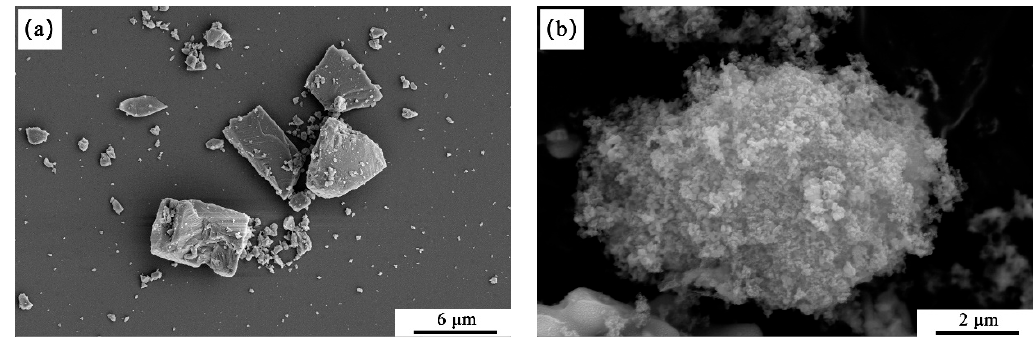
Figure 7. Scanning electron microscope (SEM) morphology: ( a ) CaF 2 powders; ( b ) CaF 2 @Al(OH) 3 composite powder.